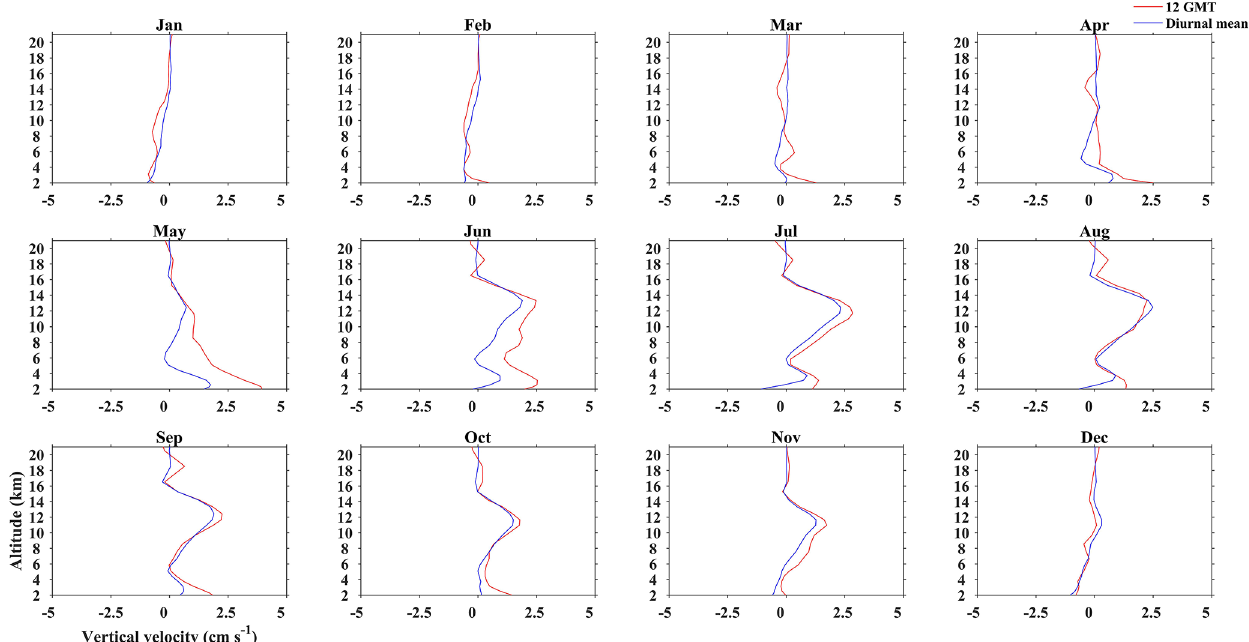
Figure 8. Height profile of w at 12:00UTC and diurnal mean (with 1h resolution) over Gadanki extracted from ERA5 during 1995–2015 (highest available time resolution).